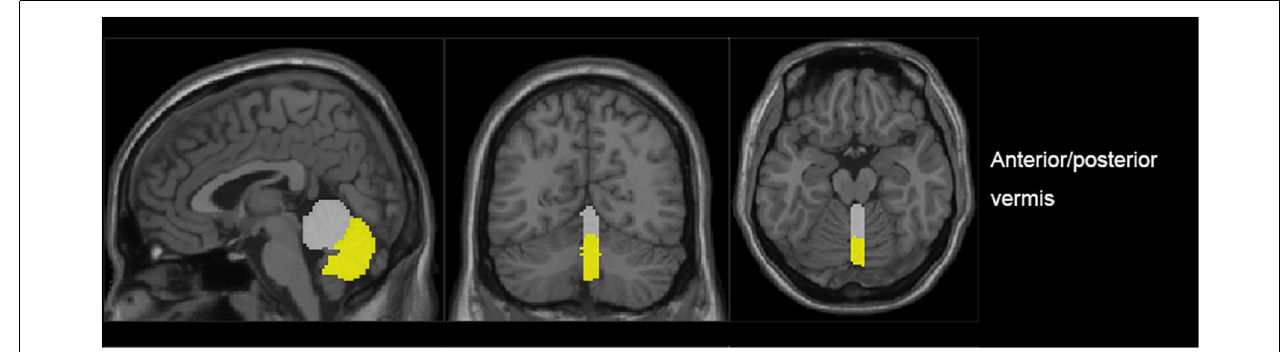
FIGURE 1 | The generated anterior (gray) and posterior (yellow) regions of interest (ROIs) in a representative